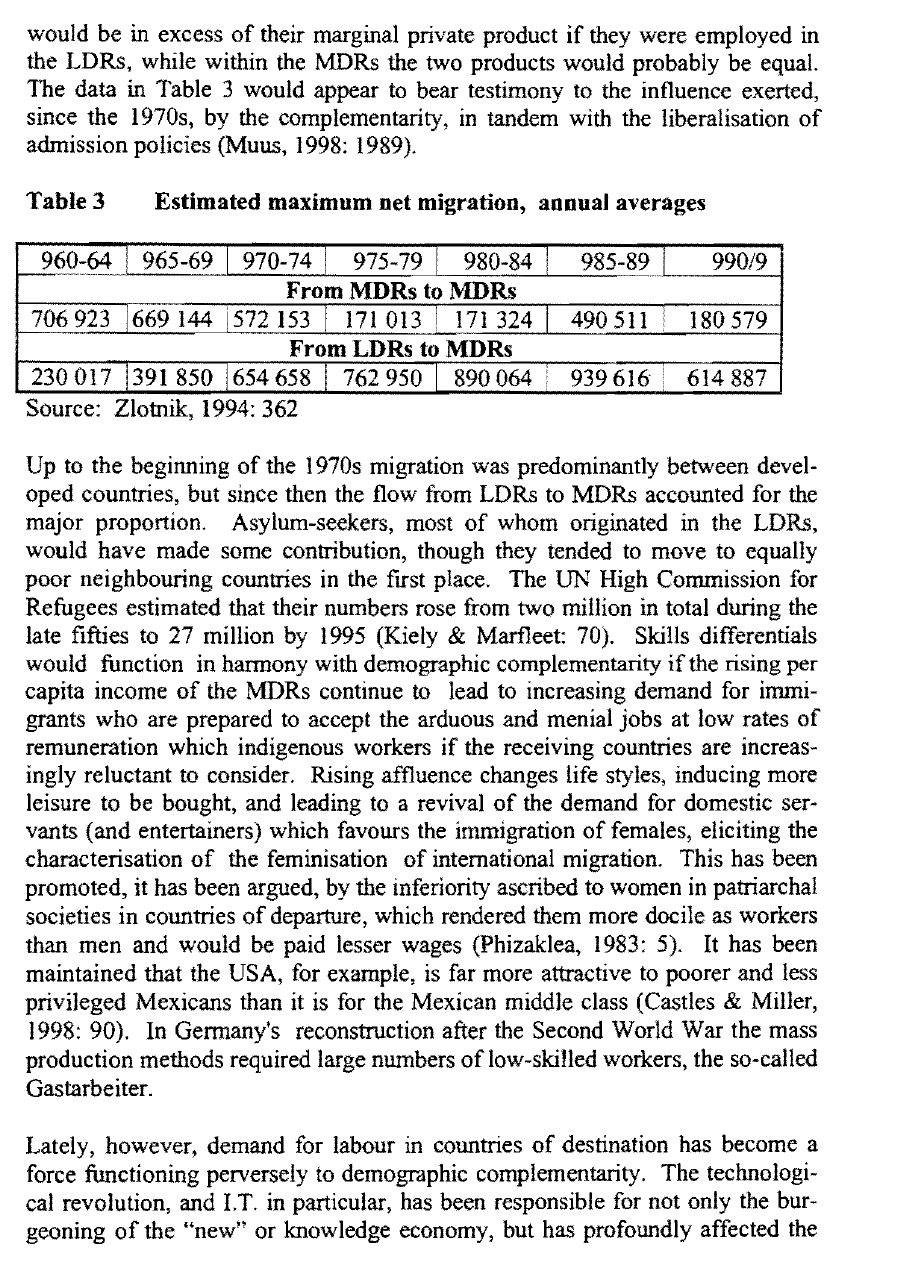
Estimated maximum net migration, annual